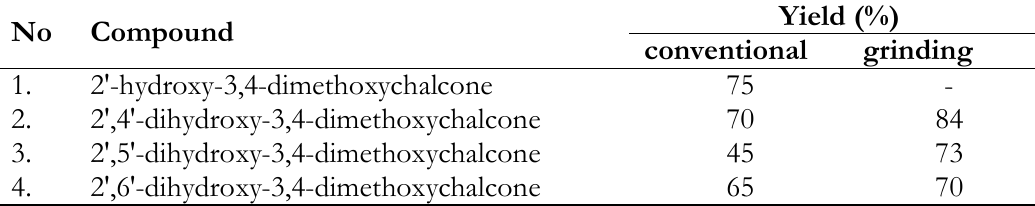
Figure 1. Scheme of synthesis hydroxyl dimethoxy chalcone derivatives. Table I. Yield of derivatives of hydroxy chalcone synthesized